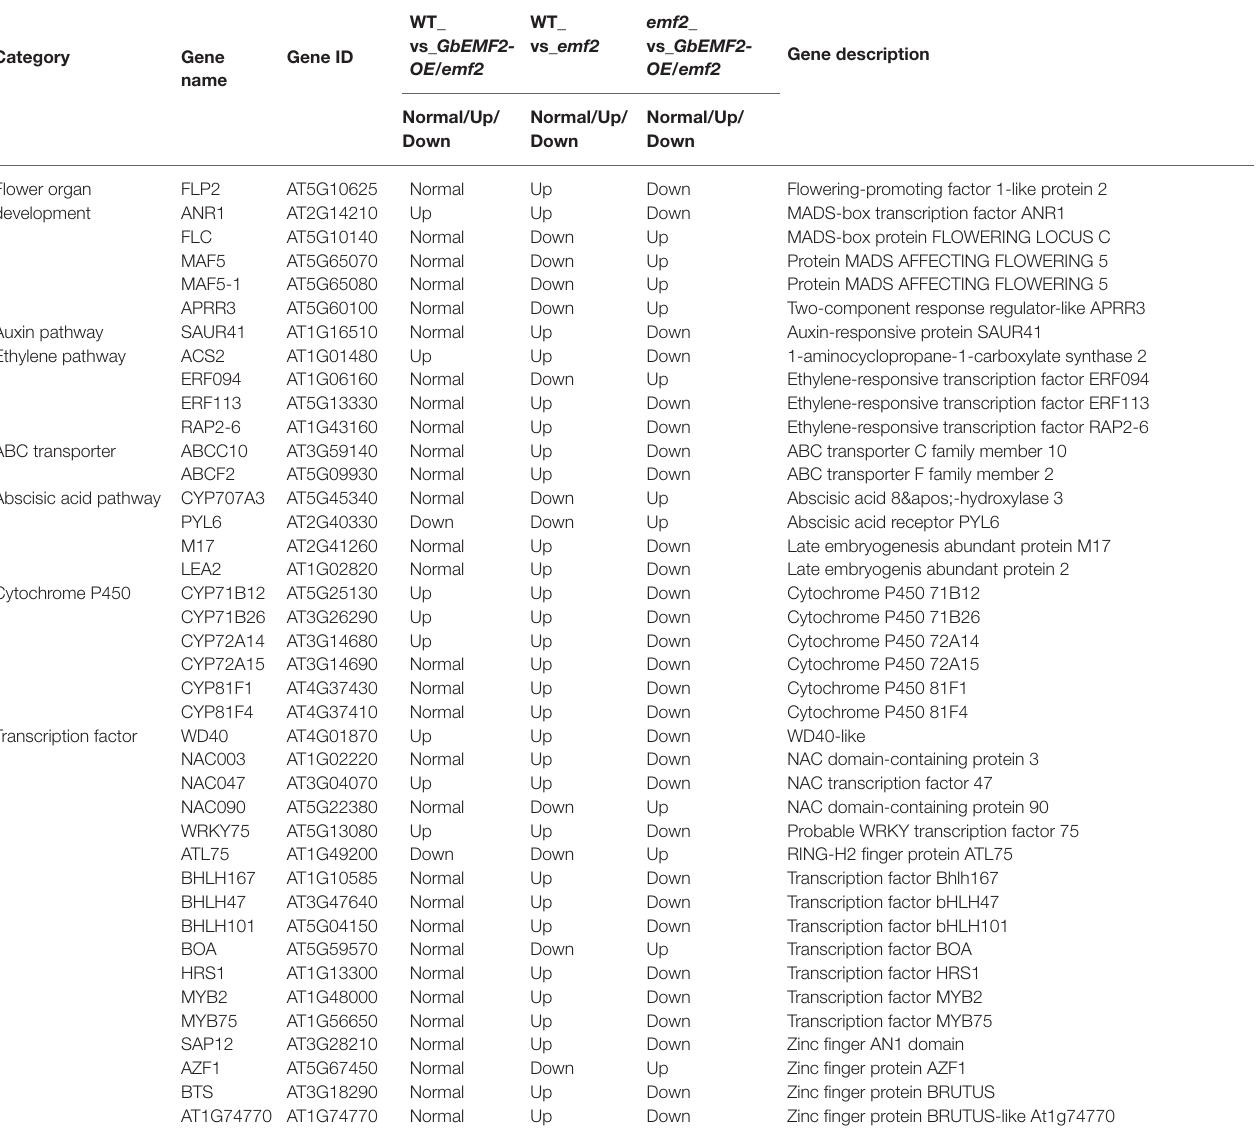
TABLE 1 | List of differentially expressed genes associated with